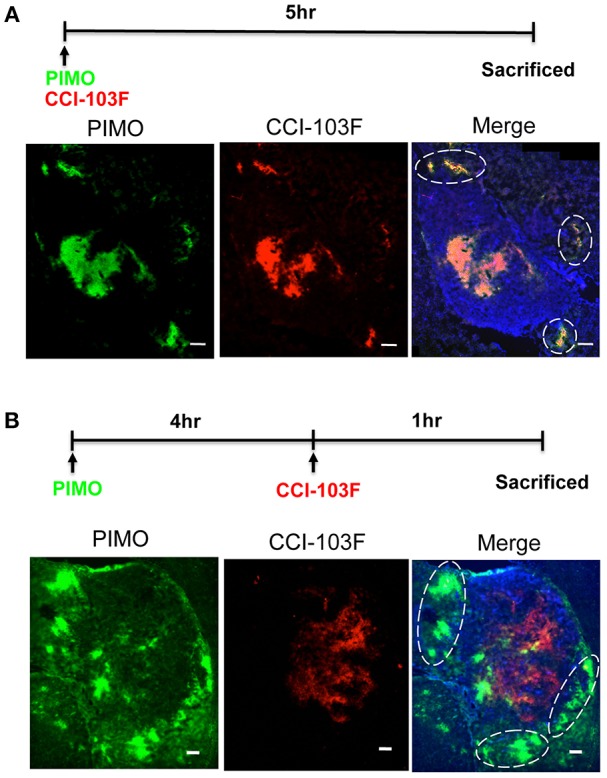
Dynamic shift of hypoxia pattern in ALTS1C1 tumors. The procedure of dual hypoxia tracer was described clearly in the materials and methods section. Dual hypoxia markers, PIMO (green) and CCI-103F (red), were injected simultaneously (A) or 5 and 1 h, respectively, before sacrifice (B) into mice. The peripheral hypoxia was circled with dotted line. Nucleus was stained by DAPI (blue). Scale bar = 200 μm.